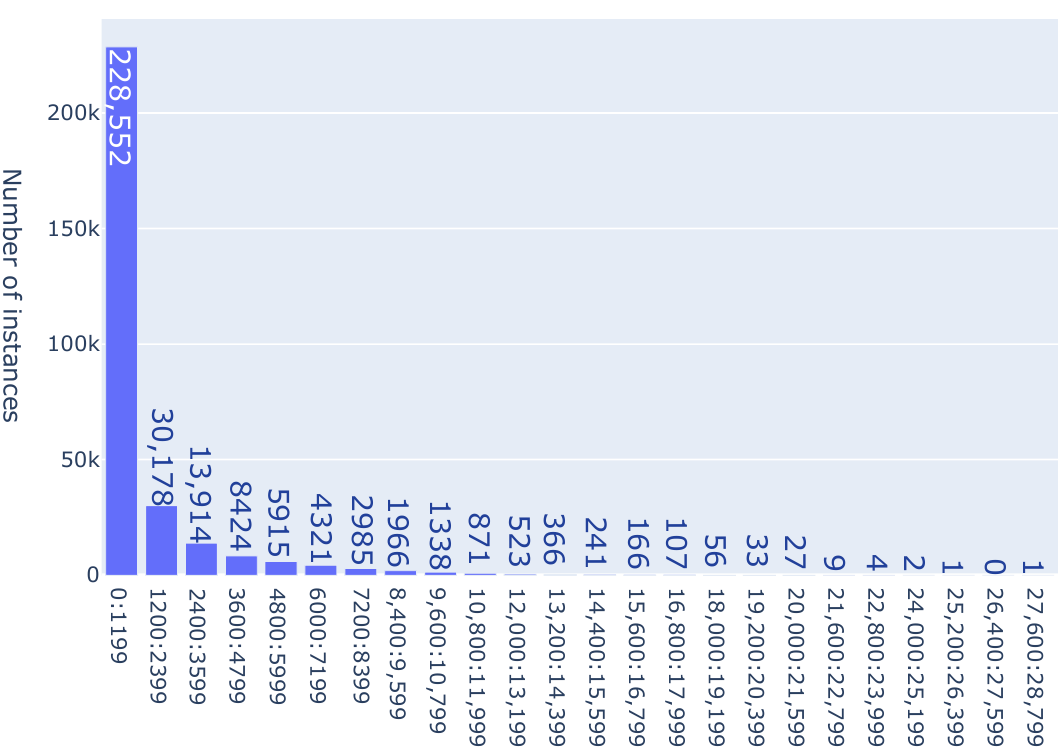
Figure 5. Number of branching points for the instances with 8